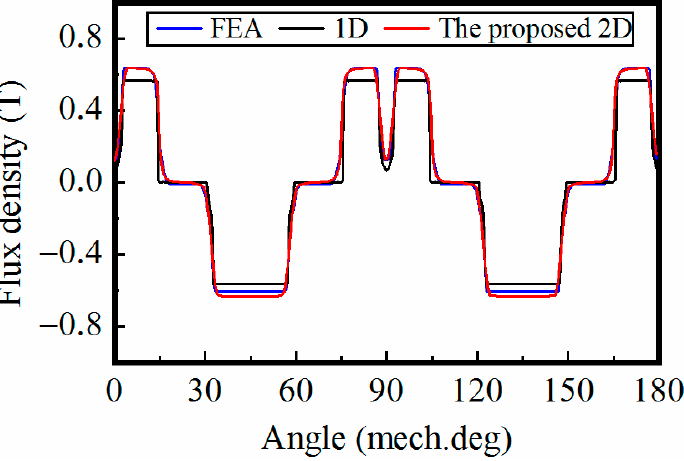
Figure 11. The slotted radial flux density distributions in the middle of air gap.